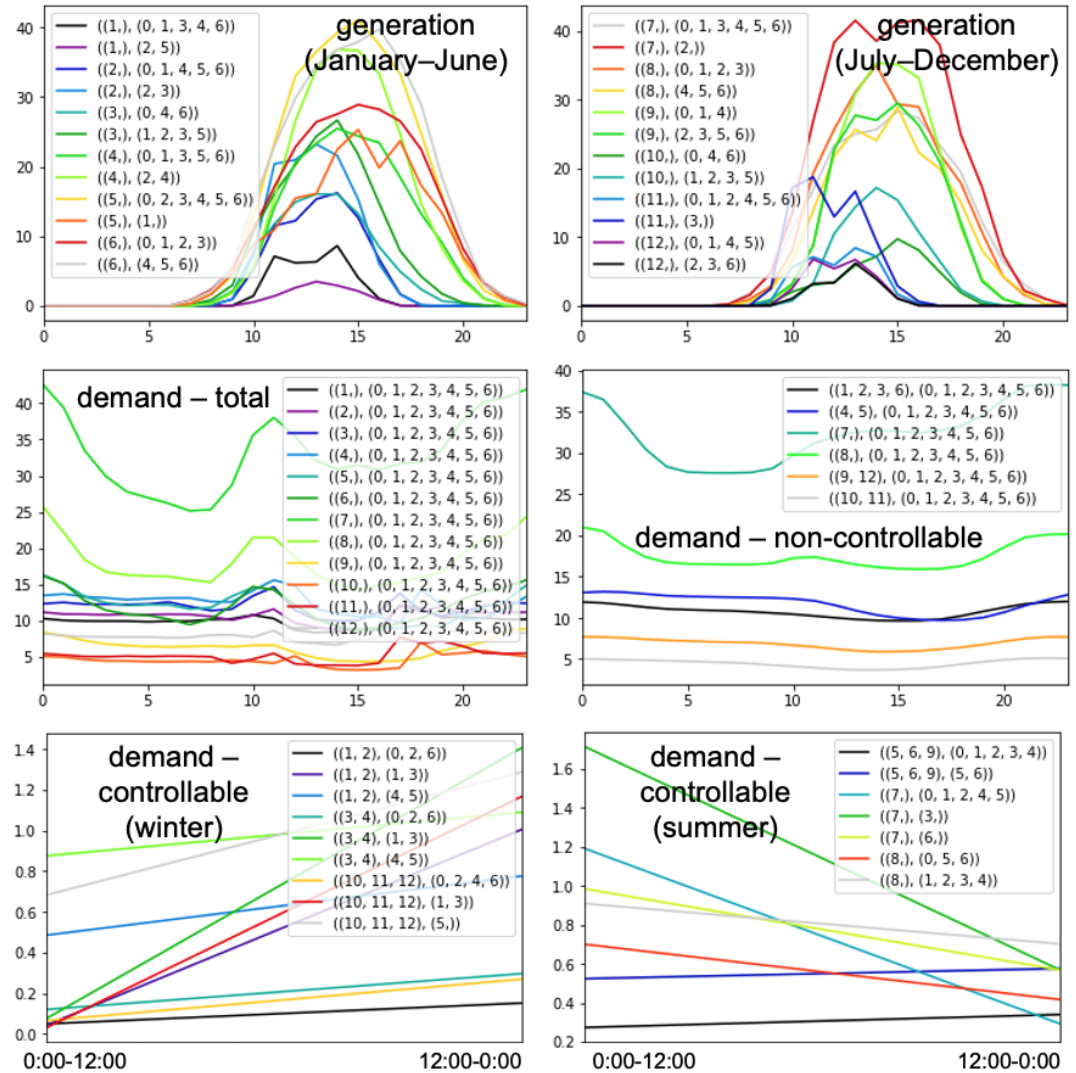
Figure A2. Average time profiles of power data from Samsø. The horizontal axes represent time of the day (h), and the vertical ones power (KW). The legends explain the clustering groups in the form (months, days of week), where days are numbered from 0 (Monday) to 6